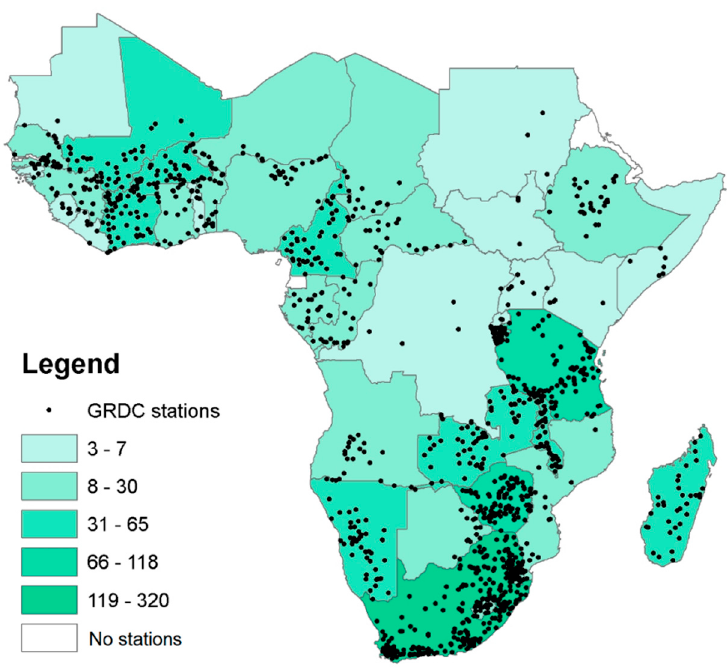
Figure 3. Spatial distribution of Global Runoff Data Center [61] stations across the studied region [50].